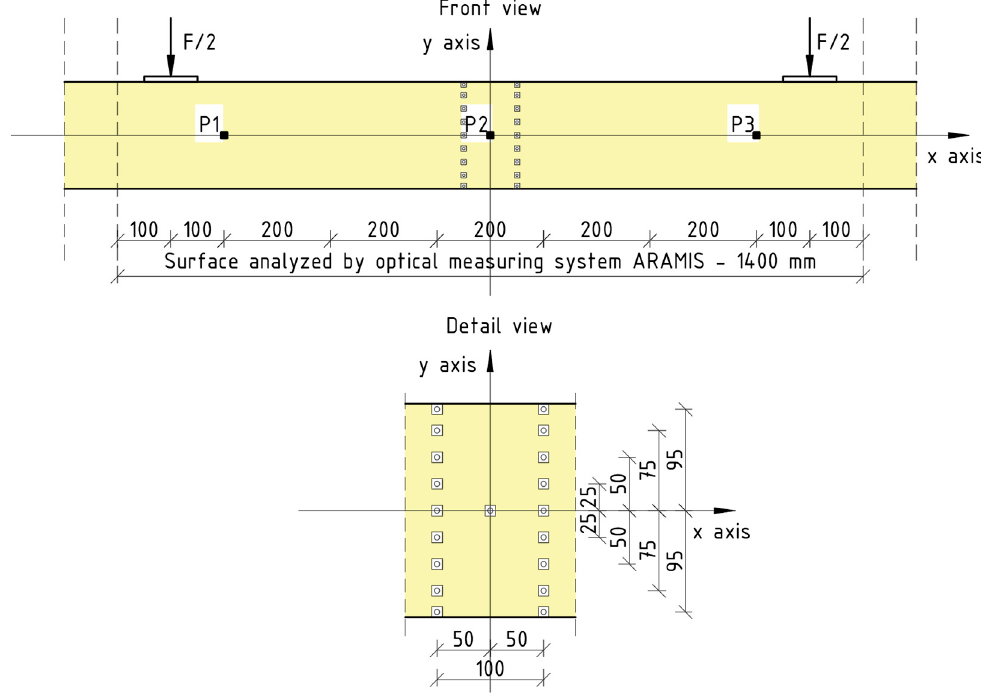
Figure 12. Arrangement of measuring points—DIC reference